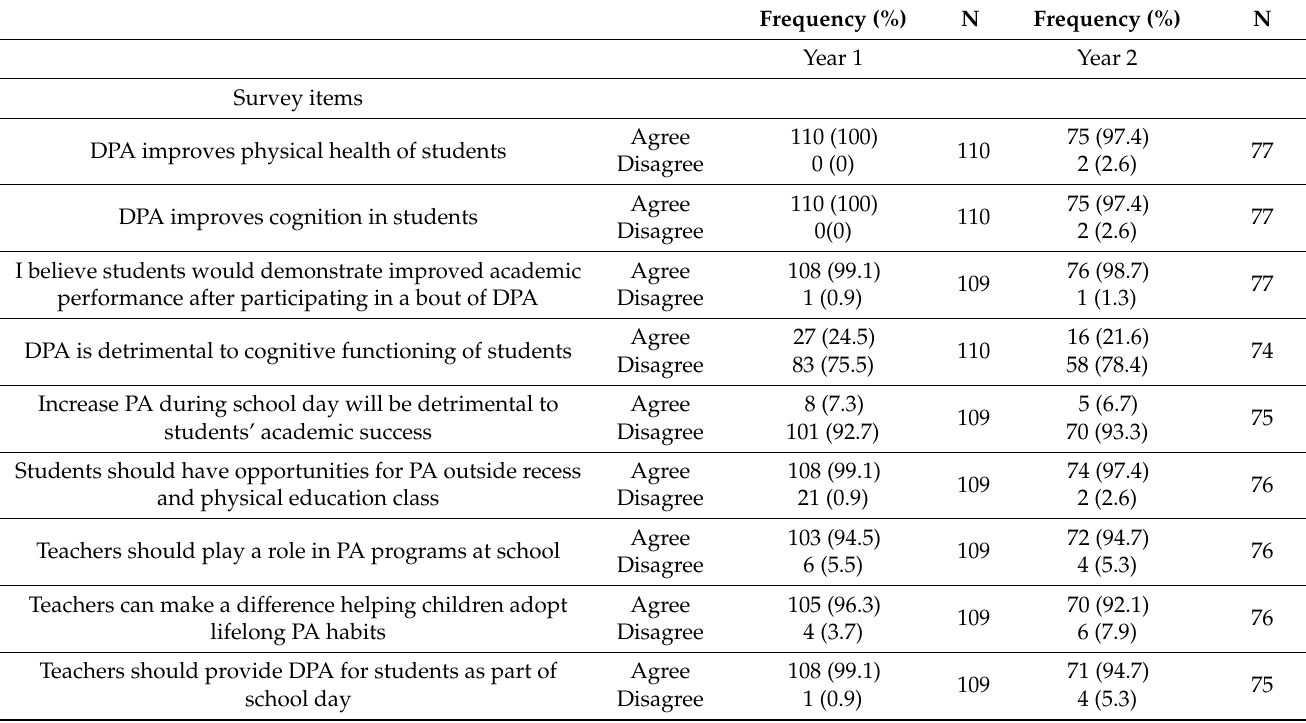
Table 2. Pre-service teachers’ perceptions of physical activity in the school and classroom.